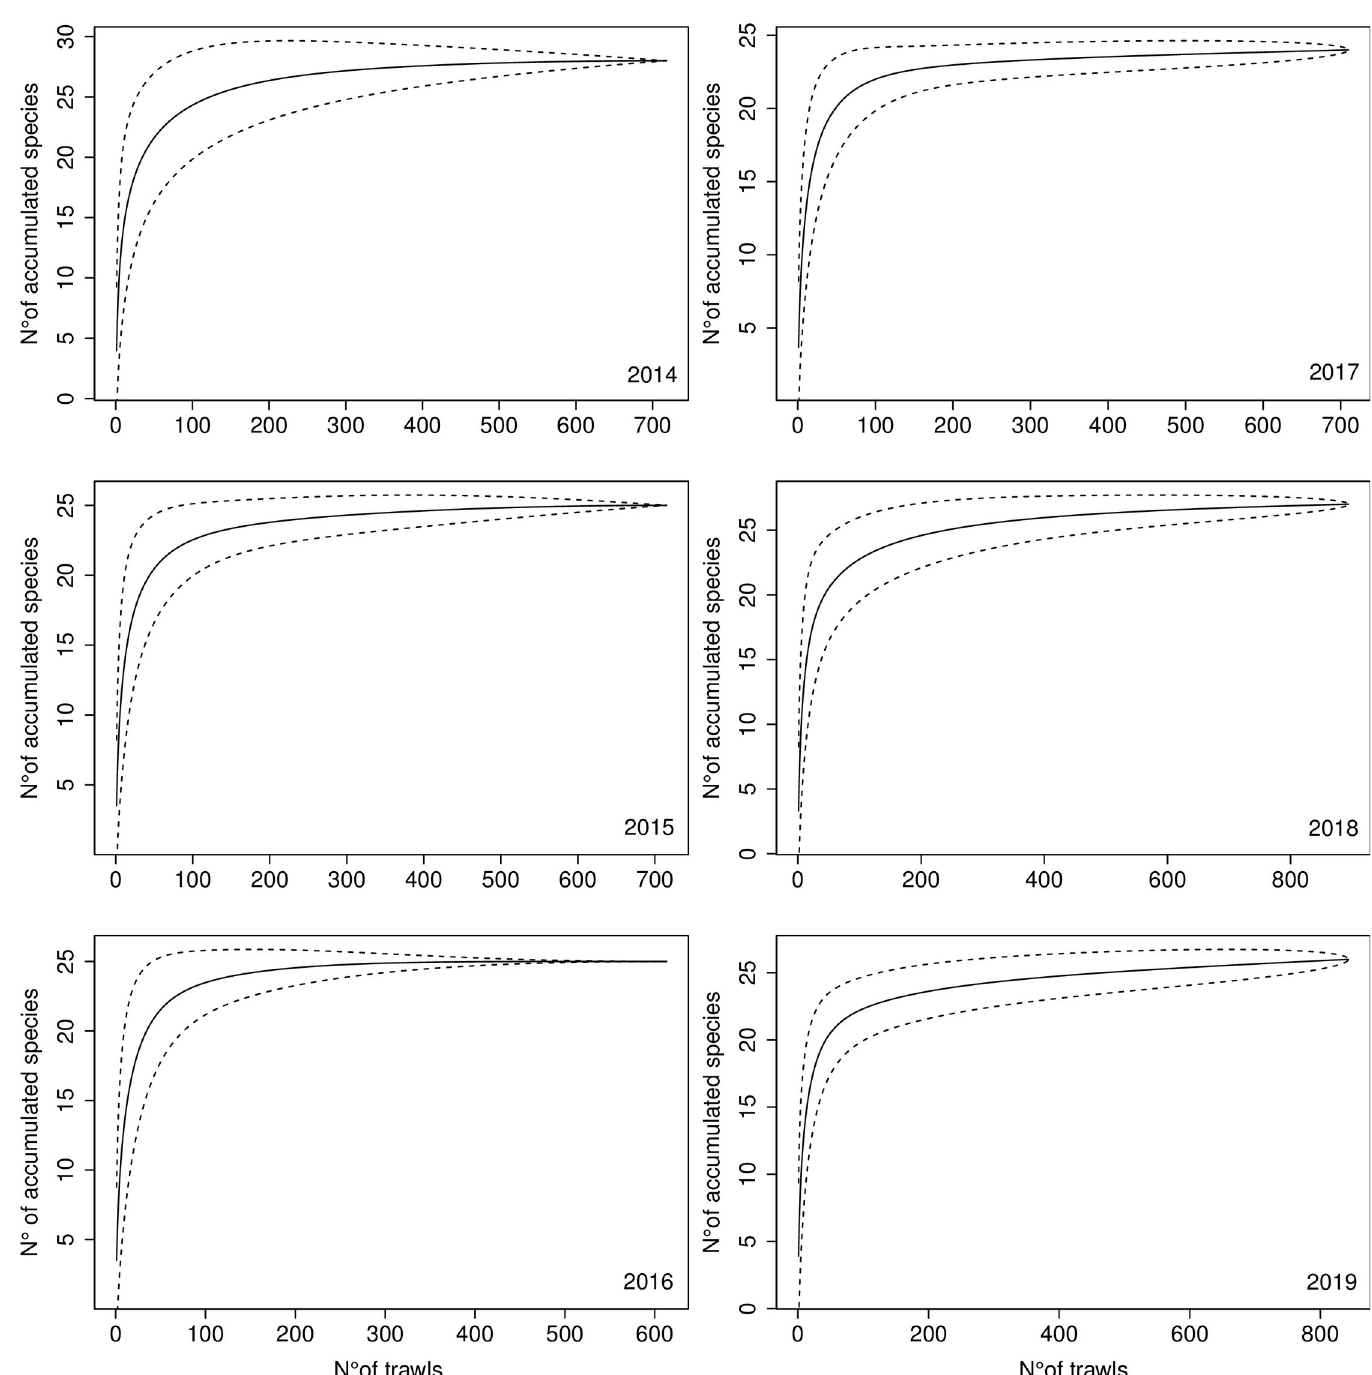
Fig 2. Cumulative curves of species found as discards in the Chilean demersal crustacean fisheries, separated for each sampled year. Dotted lines represent one standard deviation.